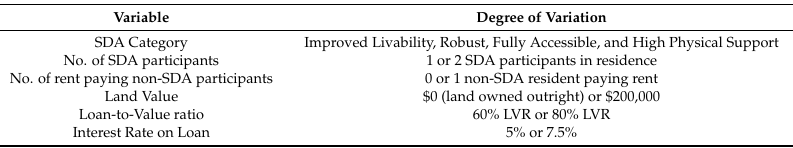
Table 2. Variable categories in financial